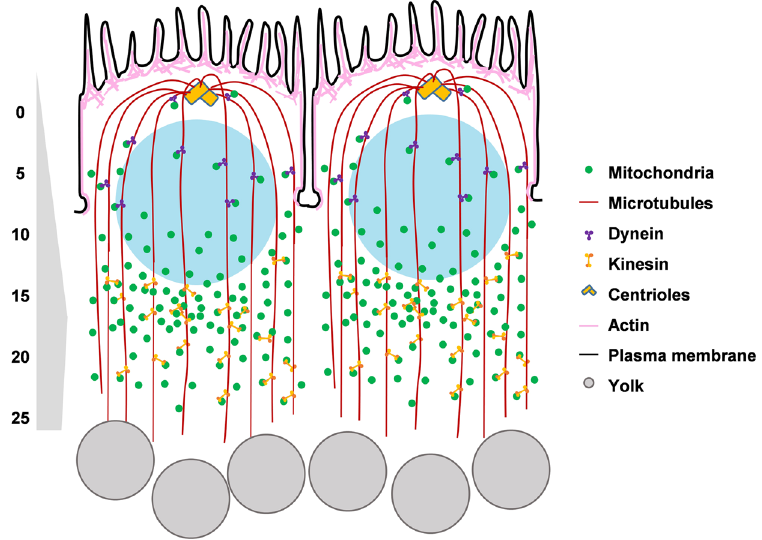
Figure 7. Summary of mitochondrial distribution and function in the Drosophila syncytial cycles. The syncytial Drosophila embryo contains dispersed mitochondria, which increase in density towards basal region of syncytial cells. Mitochondrial movement is restricted within one syncytial cell. Apico-basal concentration of mitochondria is dependent on an intact tubulin network in the syncytial blastoderm embryo. Mitochondrial ETC activity is essential for ATP production in the syncytial cells for the process of metaphase furrow formation during syncytial cycles of the Drosophila